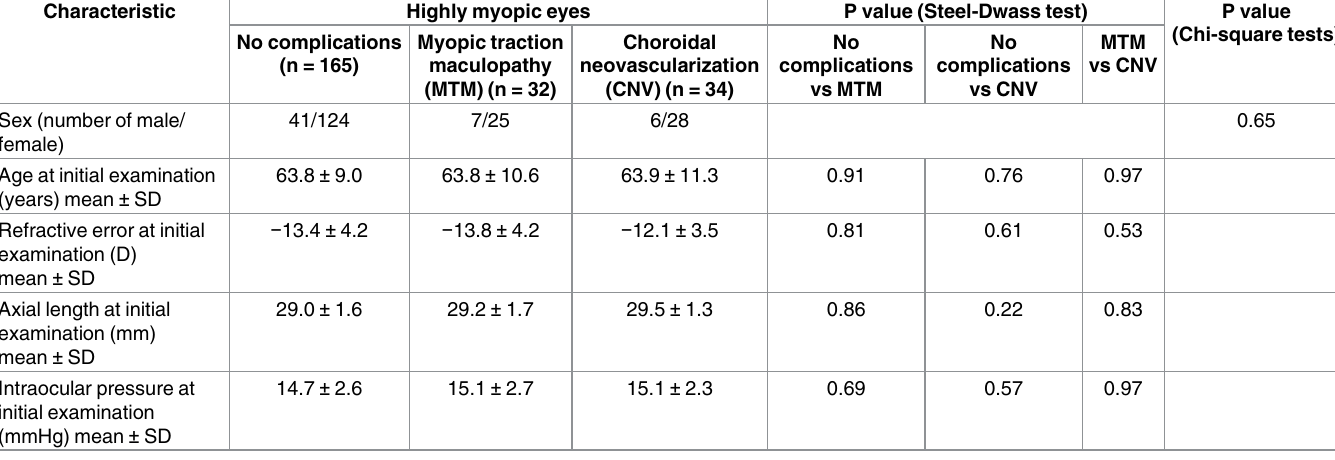
Table 3. Comparison of clinical characteristics between highly myopic eyes with no complications, with myopic traction maculopathy, and with choroidal neovascularization. Characteristic